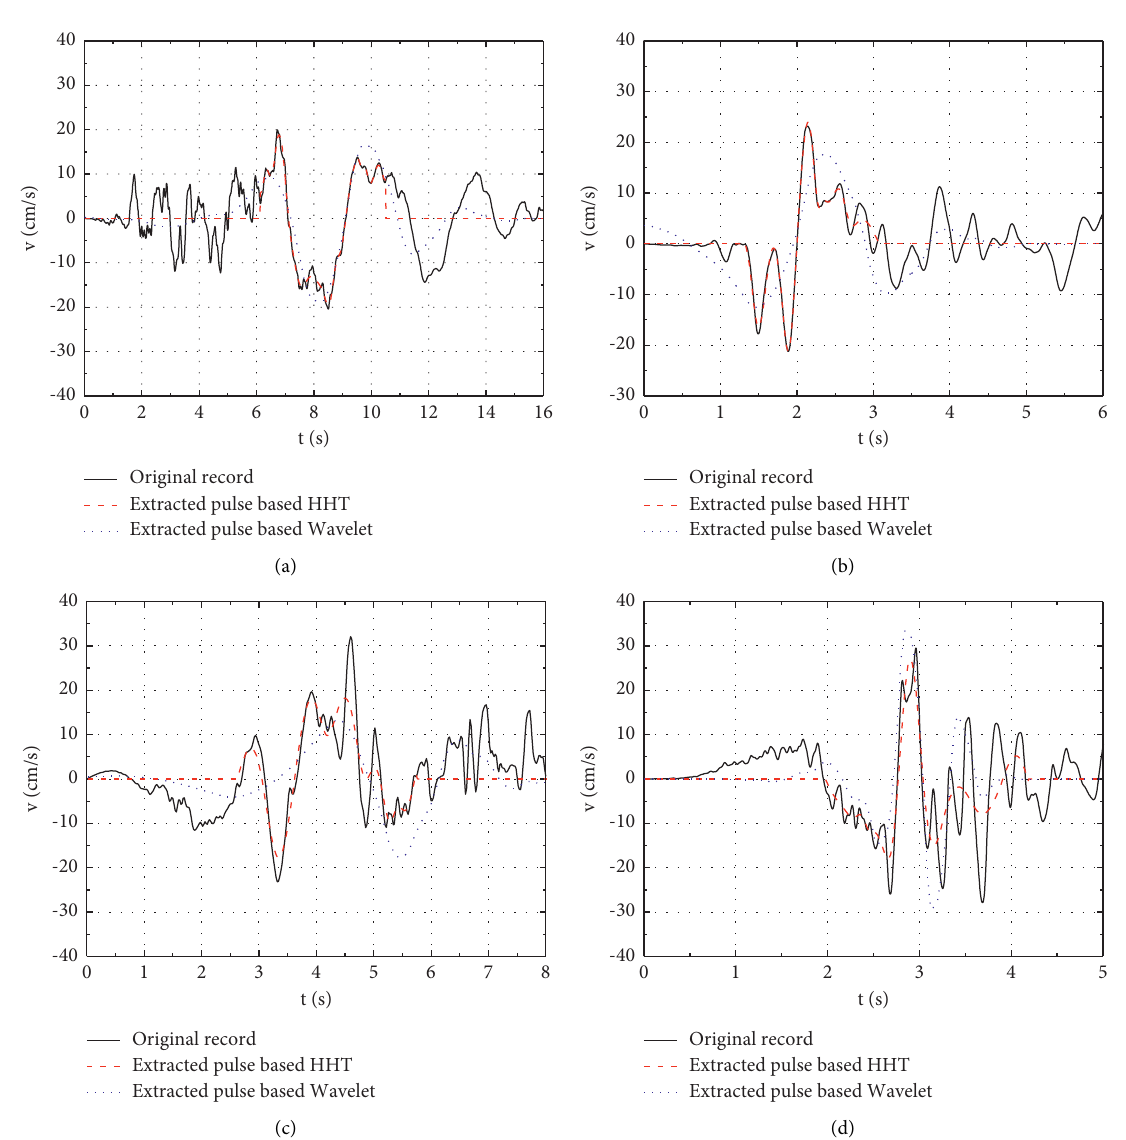
Figure 20: Comparison of extracted pulses. (a) No. 68 ground motion. (b) No. 96 ground motion. (c) No. 139 ground motion. (d) No. 407 ground